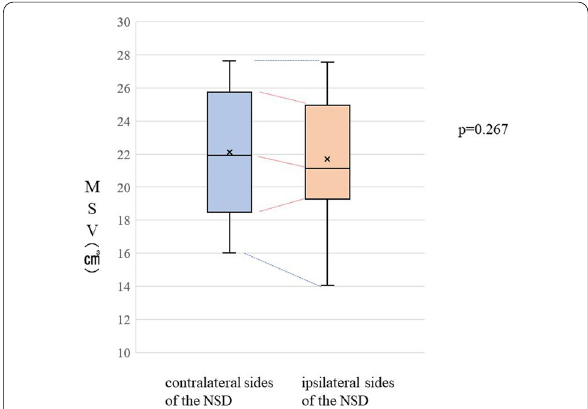
Fig. 3 Comparisons of MSV based on the presence/absence of NSD. NSD nasal septal deviation, MSV maxillary sinus